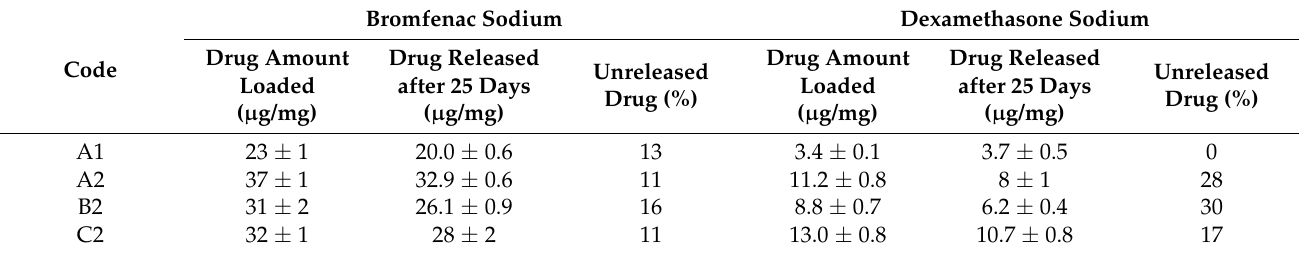
Table 3. Amounts of bromfenac sodium and dexamethasone sodium (normalized per dry hydrogel weight) loaded by the hydrogels after dual-drug loading, amounts of drug released in vitro during 25 days, and percentage of unreleased drug after 25 days. Hydrogel codes as in Table